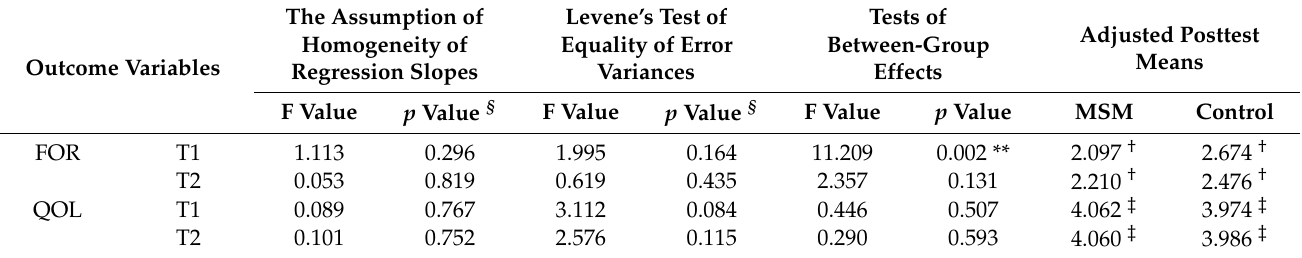
Table 3. The ANCOVA of outcome variables over time in MSM versus control group ( n =